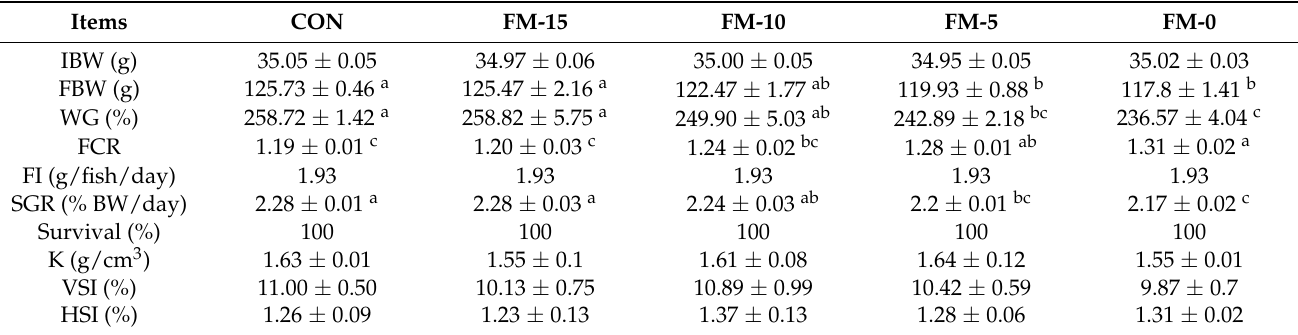
Table 3. Effect of replacing fishmeal with cottonseed protein concentrate (CPC) and Clostridium autoethanogenum protein CAP mixture on growth performance of rainbow trout.